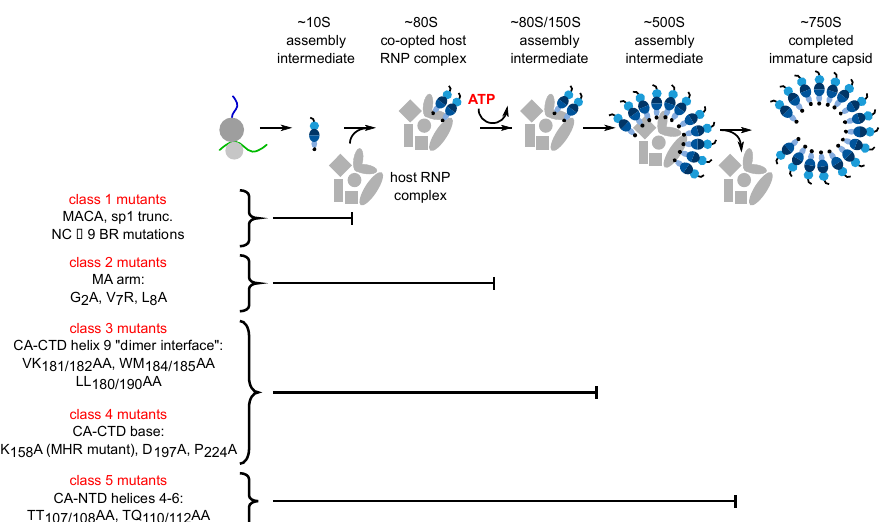
Figure 2. Each assembly-defective Gag mutant is arrested at a characteristic point in the HIV-1 capsid assembly pathway. Initial studies in the cell-free system and in HIV-1-expressing cells revealed that Gag progresses through a stepwise path- way of multiprotein complexes defined as intermediates in a pathway of assembly based on pulse-chase experiments (reviewed in [47] )). Subsequent experiments confirmed the order of intermediates in this pathway by showing that each assembly-defective Gag mutant is arrested at a characteristic point in this pathway. Altogether five different categories of mutants have been identified (Class 1–5), one for each point in the pathway. The difference between Class 3 and Class 4 being that Class 3 mutants are arrested as cytosolic ~80S complexes while Class 4 mutants are arrested as PM-associated ~80S complexes, suggesting that the ~80S assembly intermediate is the complex in which assembling Gag traffics from the cytosol to the PM. Later studies identified some of the host proteins in the assembly intermediates. Relevant references are in the text. The mechanisms by which ABCE1 and DDX6 promote Gag assembly have not been fully elucidated. However, in the case of DDX6, clues come from the known role of RNA helicases in RNP remodeling, a process by which proteins that are associated with RNAs and dictate RNA fates are replaced by other proteins [48]—thus, DDX6 could facilitate the association of Gag with viral RNA during assembly. In keeping with this possibility, in HIV-1 expressing cells DDX6 is known to colocalize with HIV-1 genomic RNA at PM sites of virus assembly and budding [49]. HIV-1 Gag is also colocalized with DDX6 and ABCE1 in situ, including at the PM at sites of budding [29,39,41,46,49,50]. Together the data sup- port a model in which, in cells, newly synthesized Gag traffics to—and assembles in— specific host RNP complexes that contain both the HIV-1 genomic RNA that is packaged into the assembling virus and host enzymes that facilitate the assembly and packaging process (Figure 3A). Additionally, by sequestering the assembly process within host RNP complexes where non-translating cellular RNAs are stored, the virus is likely able to shield assembling progeny virus from host innate immune effectors. Despite fundamental differences between the host-catalyzed and spontaneous mod- els of Gag assembly, there are many ways in which the host-catalyzed model comple- ments the self-assembly model. For example, the self-assembly studies show that RNA plays a key role in promoting Gag-Gag interactions [32]. However, unlike self-assembly reactions that contain recombinant Gag and purified RNA, the cytoplasm lacks soluble RNA, with all host and viral RNAs being instead sequestered within multiprotein com- plexes containing host RNPs [49]. Indeed, the naked viral RNA molecules shown in many viral life cycle diagrams are problematic given the lack of evidence for naked viral RNA genomes in the cytoplasm of infected cells. Data in support of the host-catalyzed model demonstrate that Gag associates with RNA in cells by trafficking to host RNP complexes,